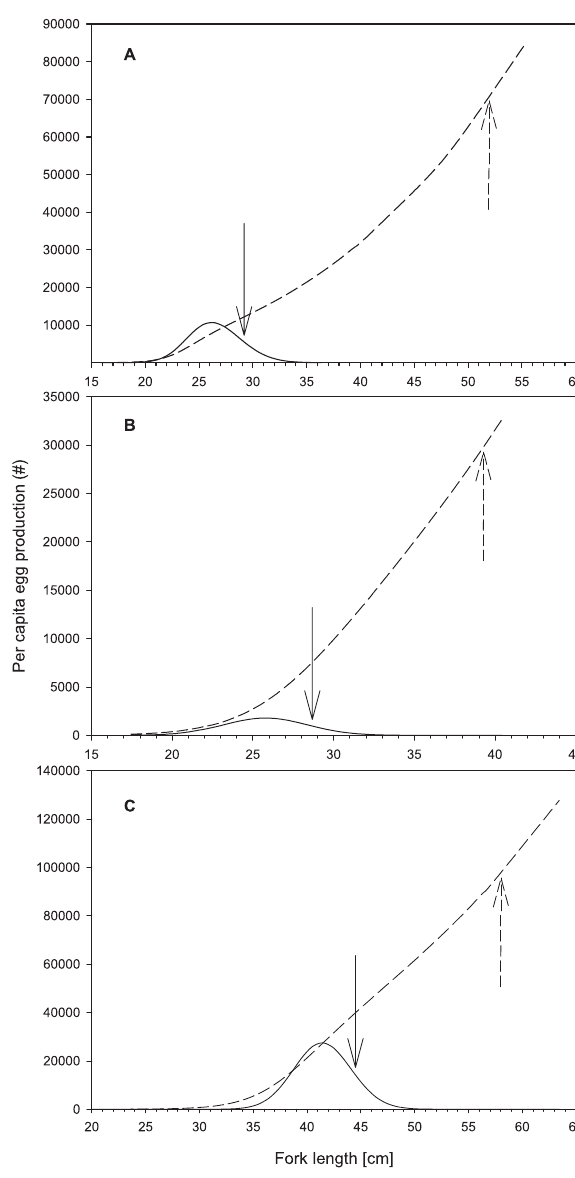
Figure 8. Estimated per capita egg production per spawning event. The solid curve represents estimates when size-specific Figure 7. Reproductive information for Chlorurus microrhinos sex ratios are considered, the dashed curve represents estimates from Fiji. ( A ) size at maturity ( L ); ( B ) size of transition ( X ); 50 50 when sex ratios are assumed to be equal and invariant. ( A ) Lut - ( C ) percentage of mature females, relative to all mature individ- janus gibbus ; ( B ) Parupeneus indicus ; ( C ) Chlorurus microrhi - uals, versus length. Females are represented by closed circles nos . Arrows indicate 90% cumulative egg production. Note that and the solid curves, males are represented by open circles and x - and y -axis scales the dashed curve.